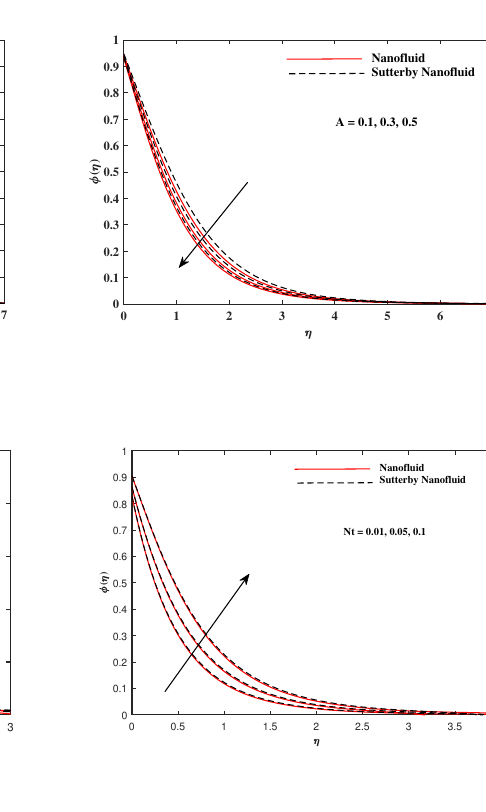
Figure 10. θ ( η ) fluctuate with Γ u , Γ v , and Γ T .